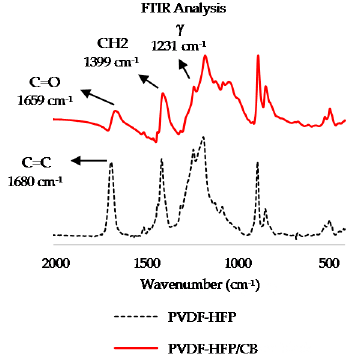
Figure 4. FTIR analysis of PVDF-HFP (in dotted black) and PVDF-HFP/CB (in solid red).